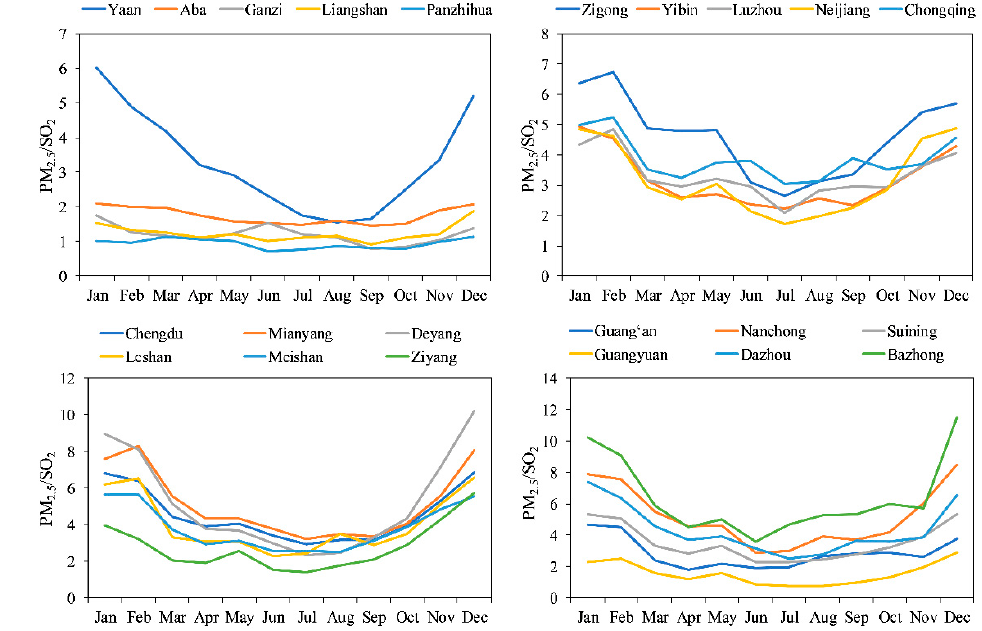
Figure 6. The monthly average PM 2 . 5 /SO 2 ratio of each city.